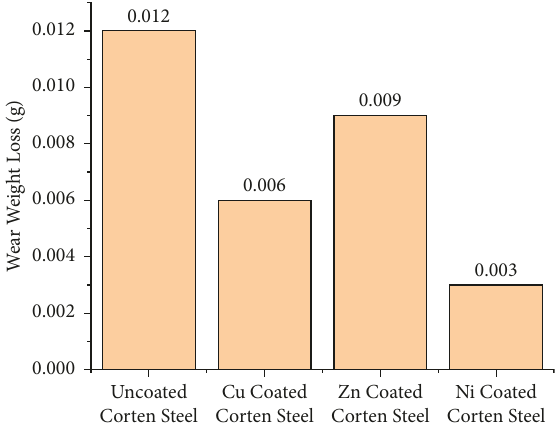
Figure 11: Wear test weight loss of uncoated and coated corten